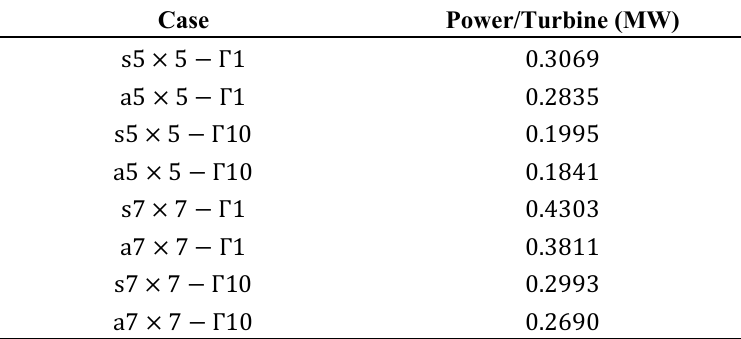
Table 2. The time-averaged power output for different